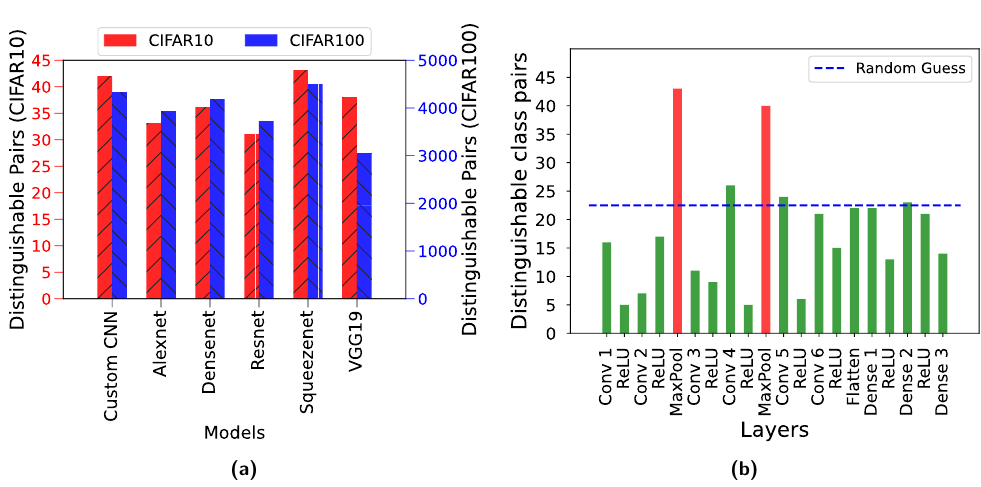
Figure 9: (a) Number of class pairs distinguishable by different CNN models trained with differential privacy on CIFAR10 (out of 45) and CIFAR100 (out of 4950) dataset (Intel Xeon processor)(b) Number of class pairs (out of 45) distinguishable in each layer of Custom CNN with Max Pooling trained with differential privacy(CIFAR10)